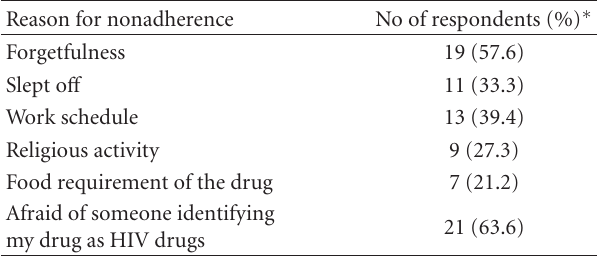
Table 4: Reasons for missing drugs among the 33 respondents that had less than 95%